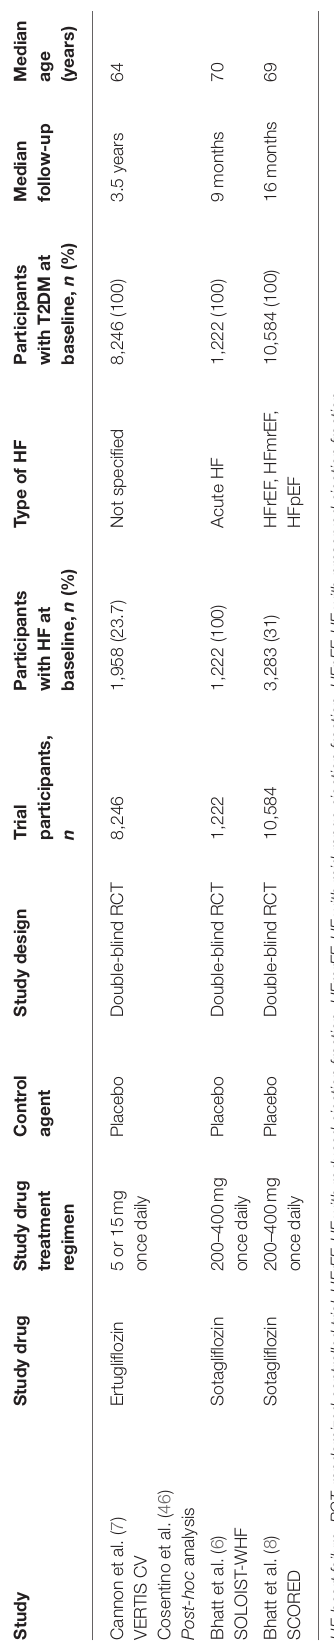
reduction of all-cause mortality ( p = 0.19 and 0.24, respectively). Subgroup Analyses for the Primary Composite Outcome According to Patients’ Baseline Data Sex Both men and women profited from treatment with SGLT2 inhibitors. As shown in Figure 5A , these benefits were even more pronounced in the female population, with a resulting RRR of 30% (RR = 0.70, 95% CI = 0.57–0.86, p = 0.0007, I 2 = 13%) as compared to a RRR of 26% in male patients (RR = 0.74, 95% CI = 0.65–0.84, p < 0.00001, I 2 = 25%). Age As shown in Figure 5B , the SGLT2 inhibitors reached statistical significance in patients < 65 years of age and in patients 65 years or older for the reduction of the composite endpoint, with RRRs of 25% and 28%, respectively (RR = 0.75, 95% CI = 0.65– 0.86, p < 0.0001, I 2 = 0%; RR = 0.72, 95% CI = 0.65–0.81, p < 0.00001, I 2 =